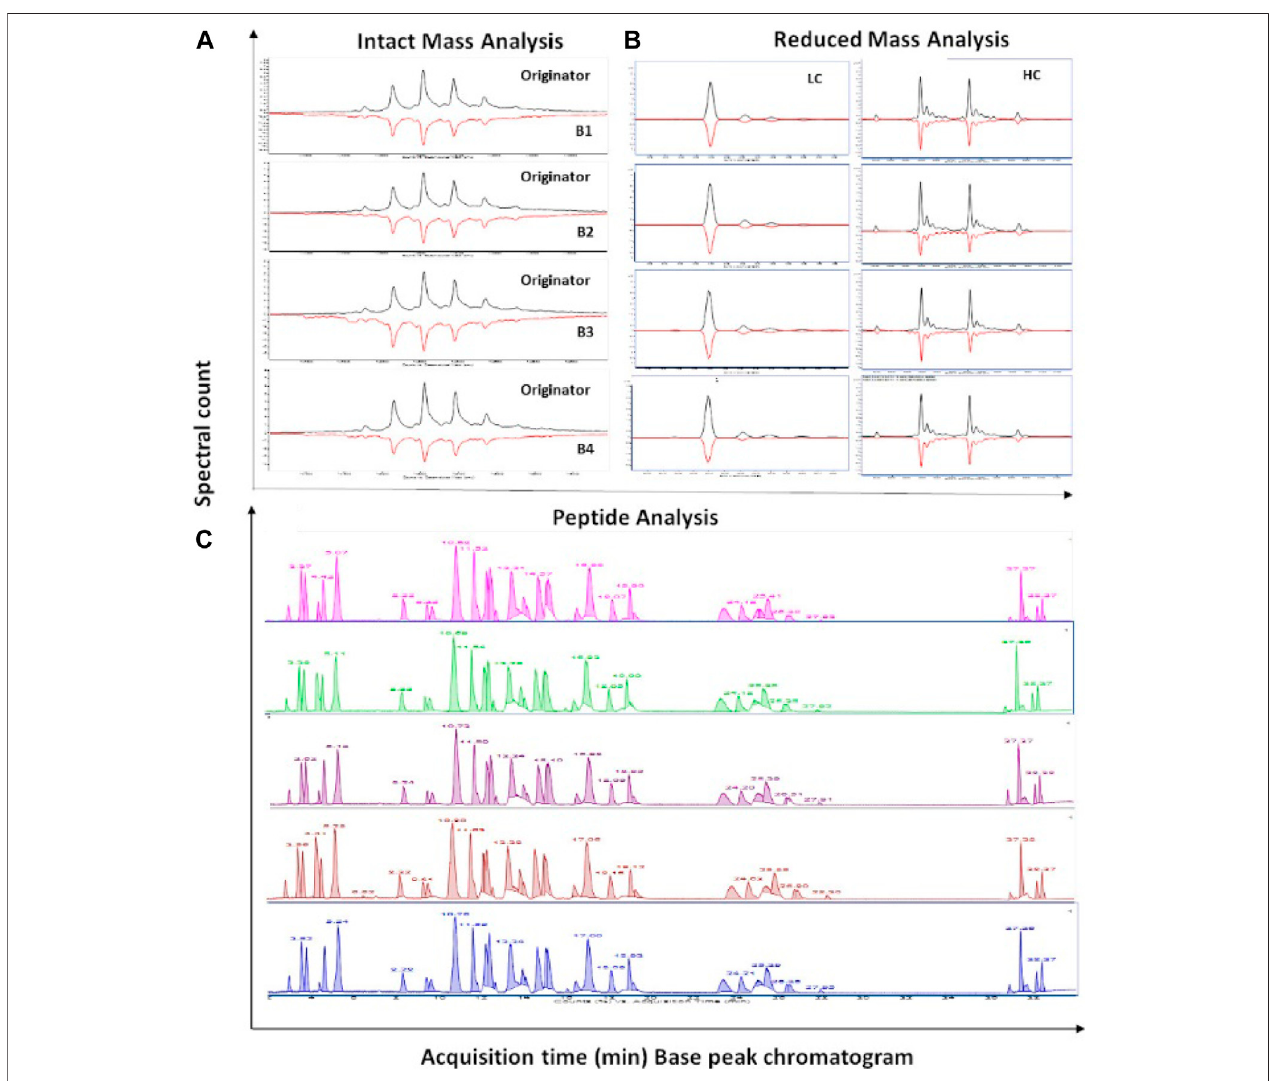
FIGURE 5 | RP-LC-MS based primary structure biosimilarity assessment of trastuzumab originator and biosimilars as adapted from Joshi and Rathore, 2020. (A) mirror plot of Intact pro fi le, (B) mirror plot of reduced pro fi le and (C) stacked chromatograms of trastuzumab biosimilars compared with originator.